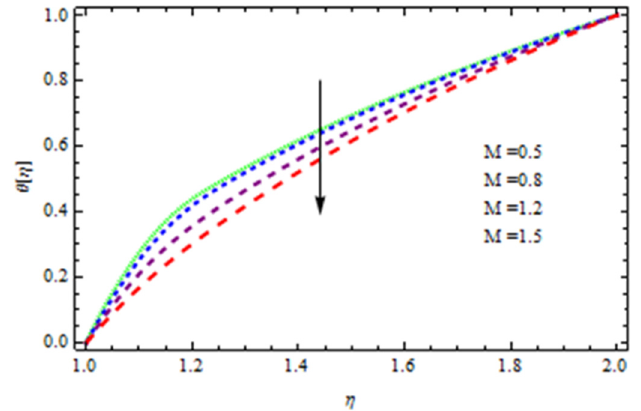
Figure 18. Temperature distribution in Vogel’s model for M.